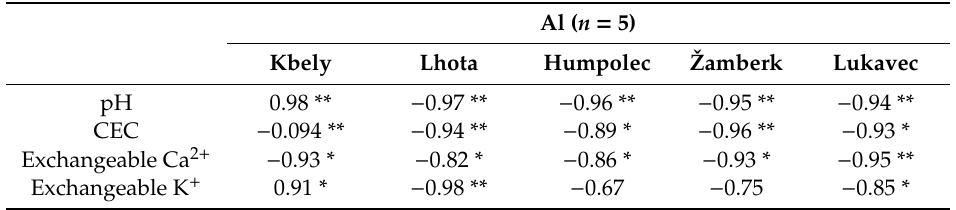
and K + after addition of four levels of biochar (0.5%, 2%, 4%, and 8%) at the 12th week of